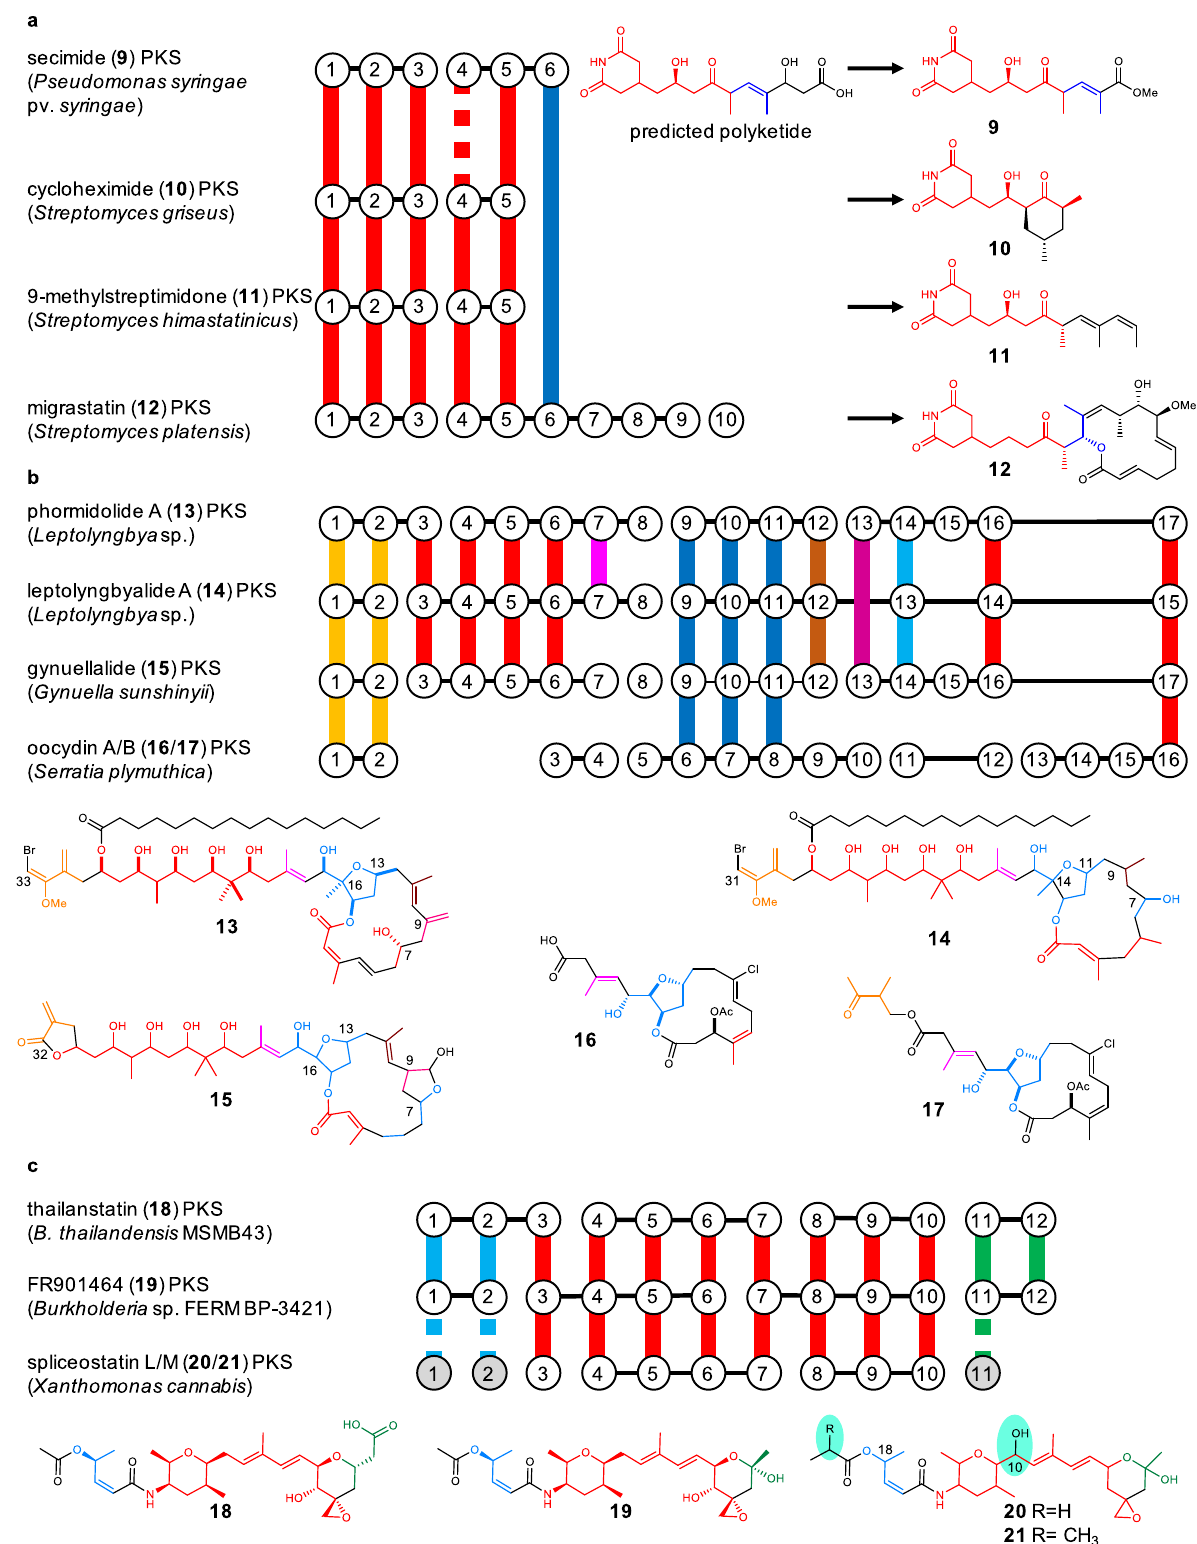
Fig. 5 Conserved motifs identi fi ed in PKSs for glutarimides, phormidolides, oocydins, and spliceostatins and their corresponding metabolites. a Selected glutarimide-type PKSs. b Phormidolide-type and oocydin PKSs. c Spliceostatin-like PKSs. Conserved PKS module blocks and corresponding polyketide moieties are shown in the same colors. Vertical lines in PKS representations: KSs that cluster together in a phylogenetic tree; black horizontal lines: PKS protein scaffold; gray circles: PKS modules that harbor matching KS domains and domain architecture, but were identi fi ed on other, disconnected contigs in the genomic data; discontinuous vertical lines: manually assigned phylogenetic match, green highlights: structural differences compared to previously described